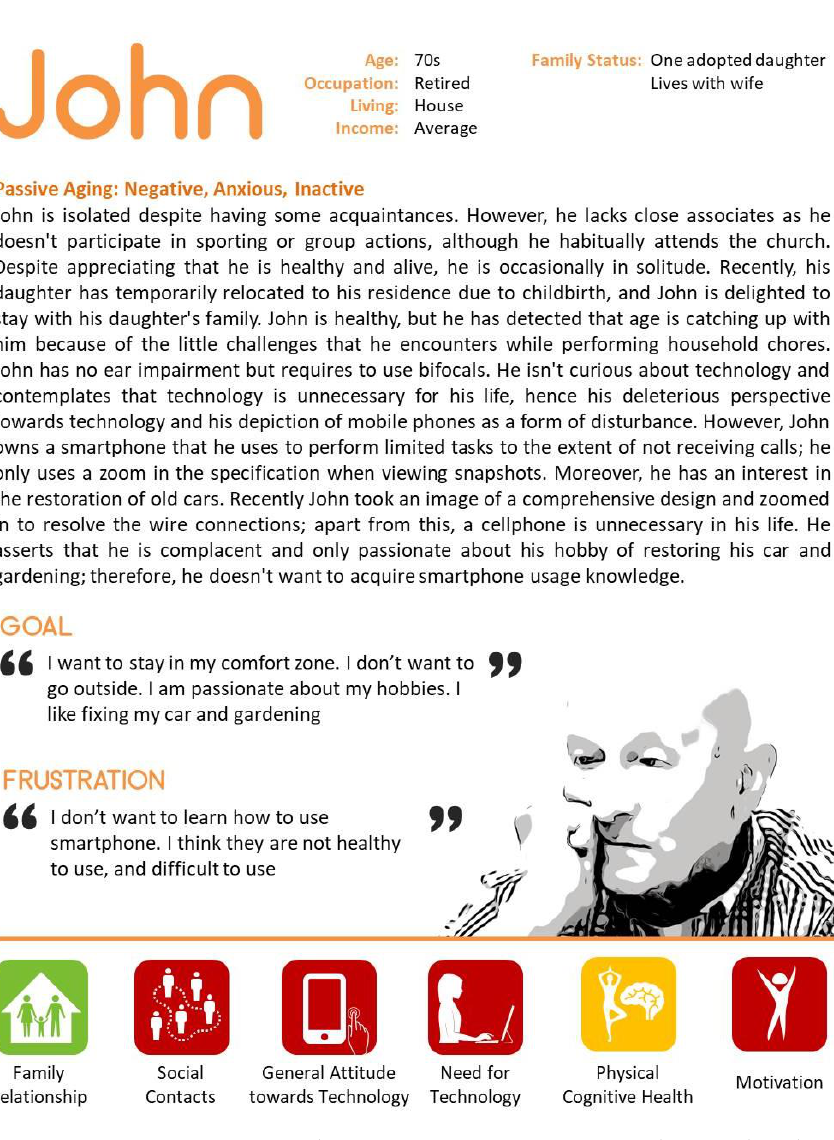
Figure 2. Case 2—Representative character to present negative attitude towards technology.